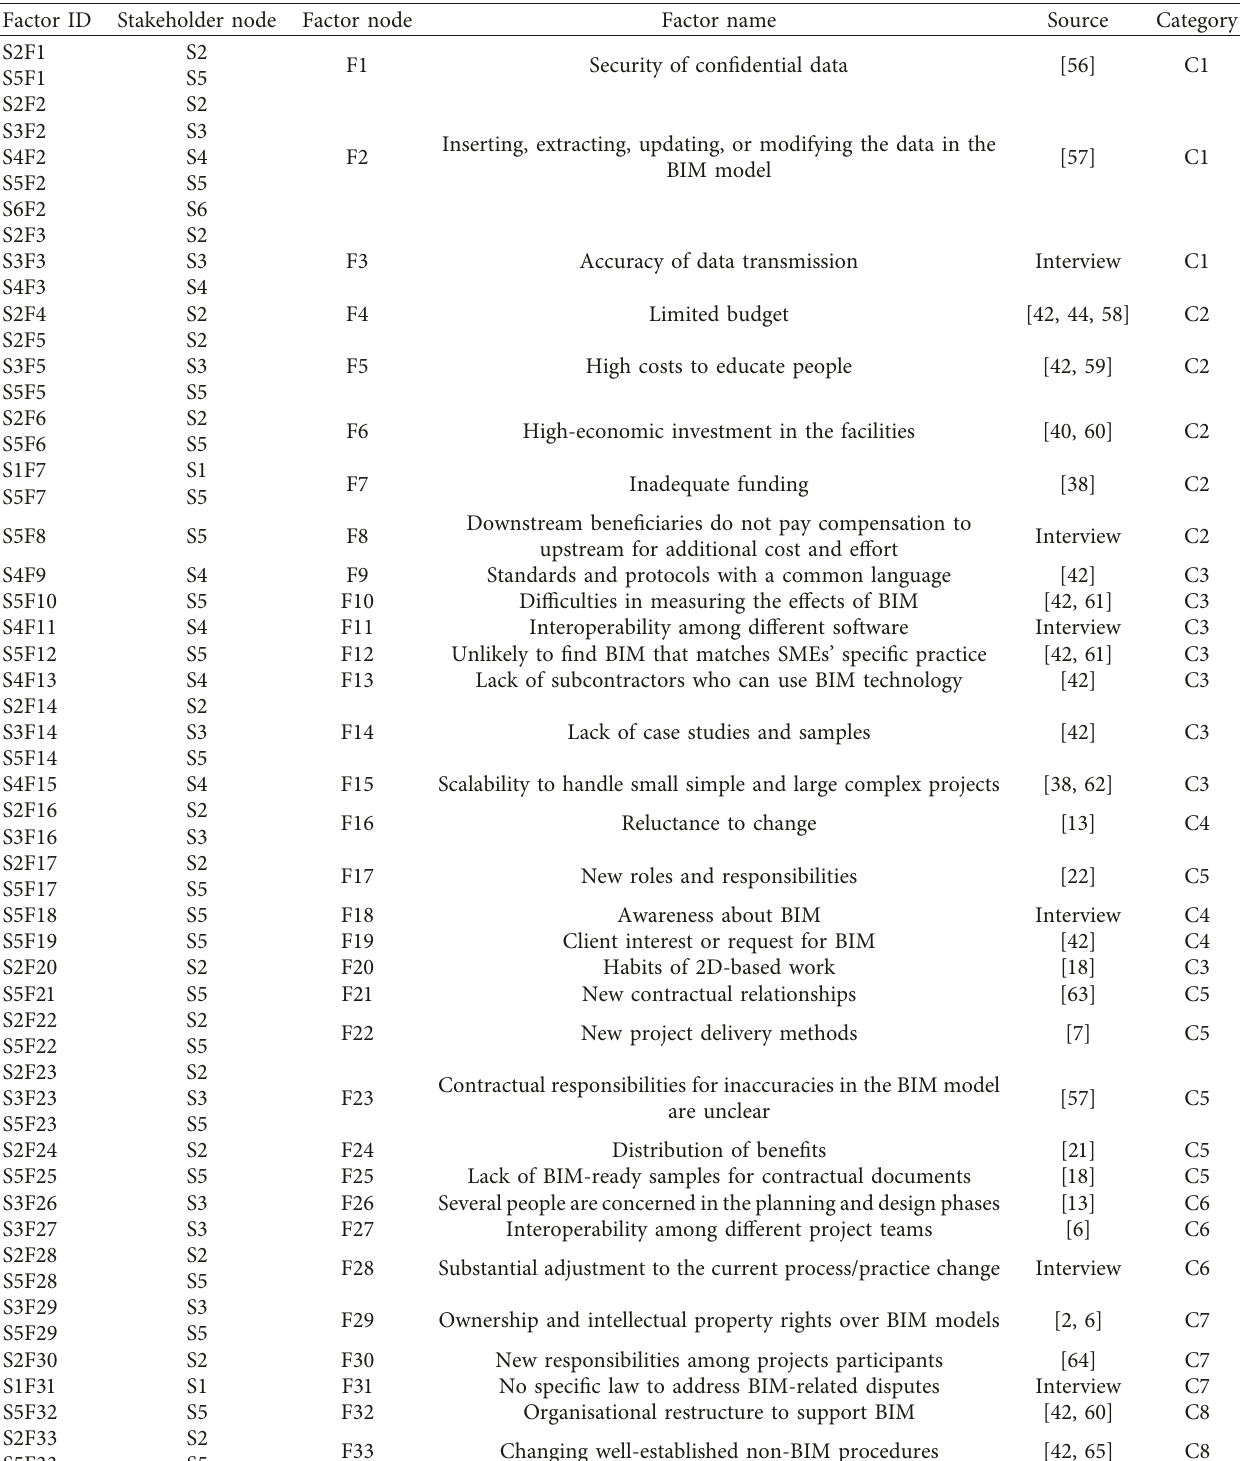
Table 1: Influencing factors and relevant